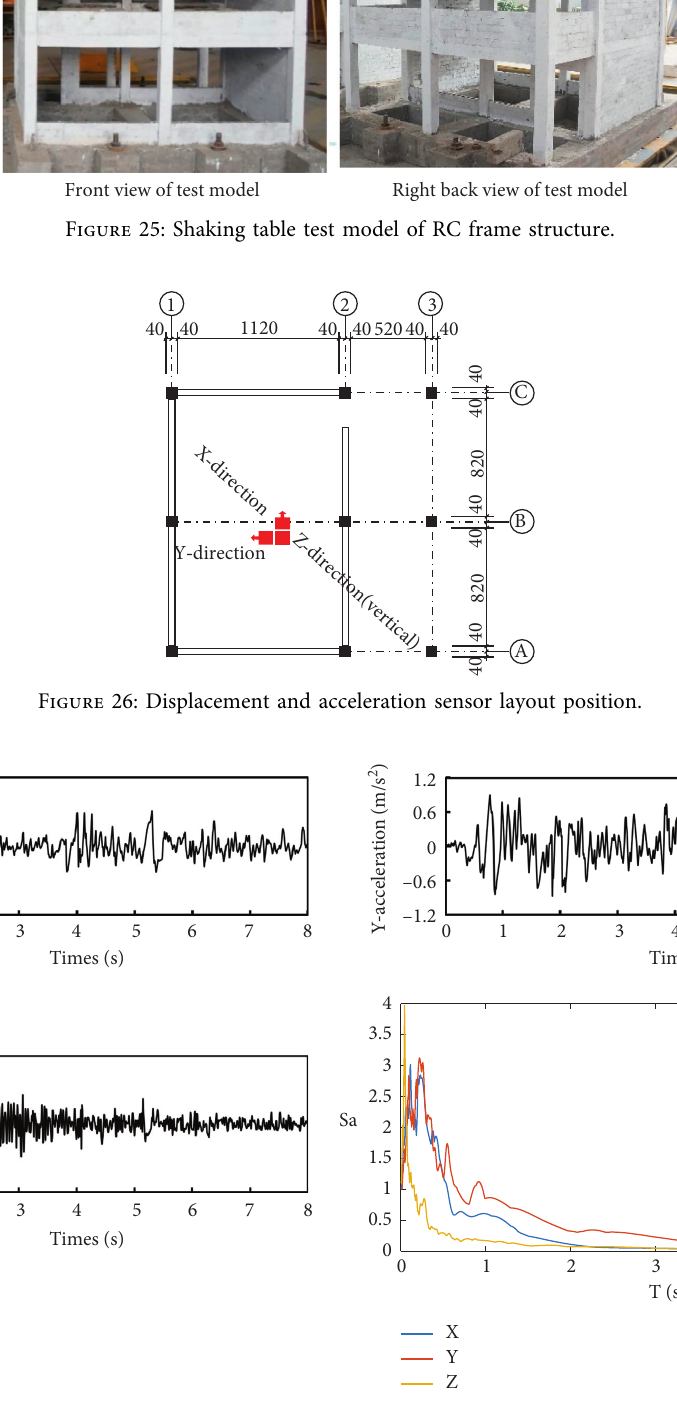
Figure 27: X , Y , Z earthquake acceleration time history and response